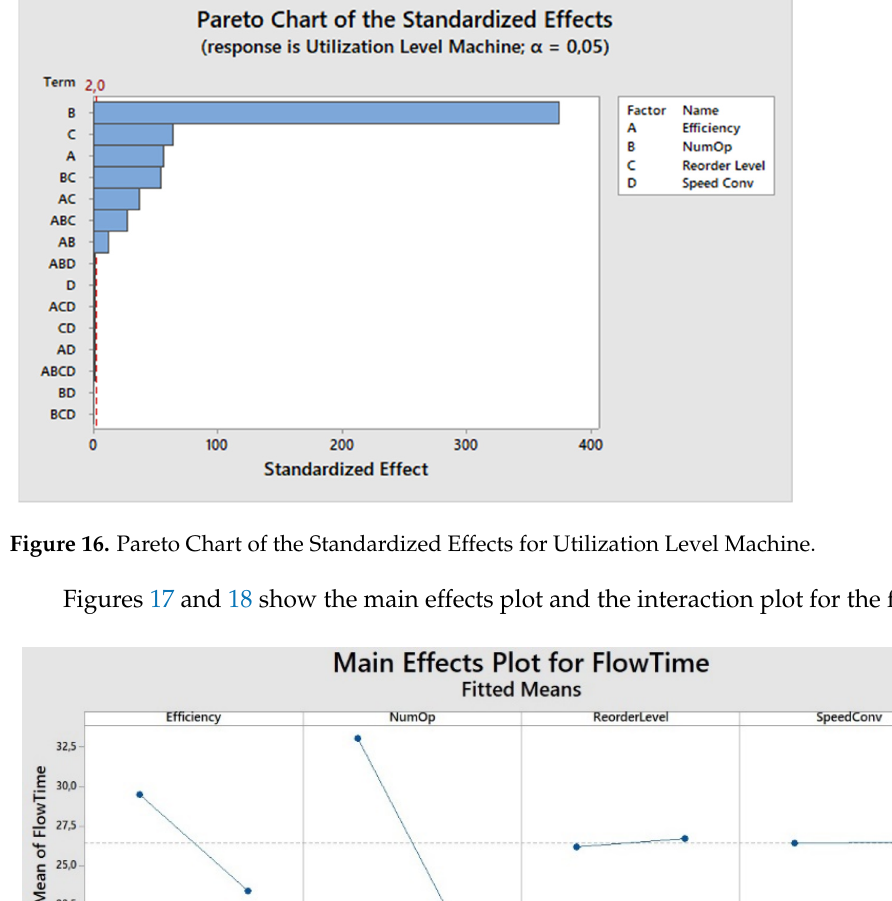
Figure 15. Interaction Plot for Utilization Level Machine.